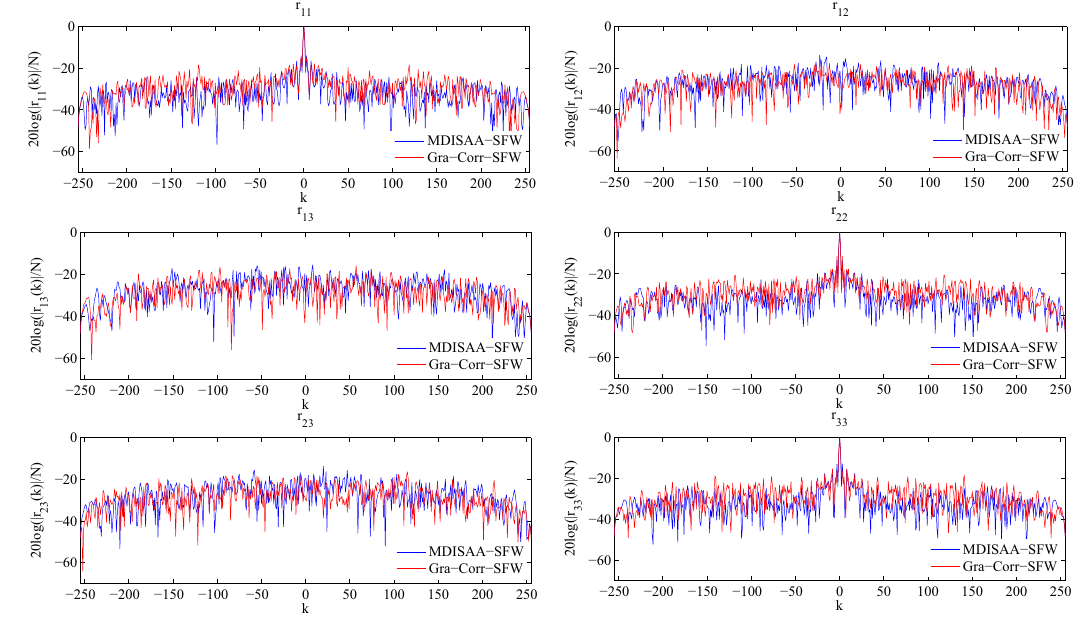
Figure 7. The correlation levels of the waveform sets designed by MDISAA-SFW and